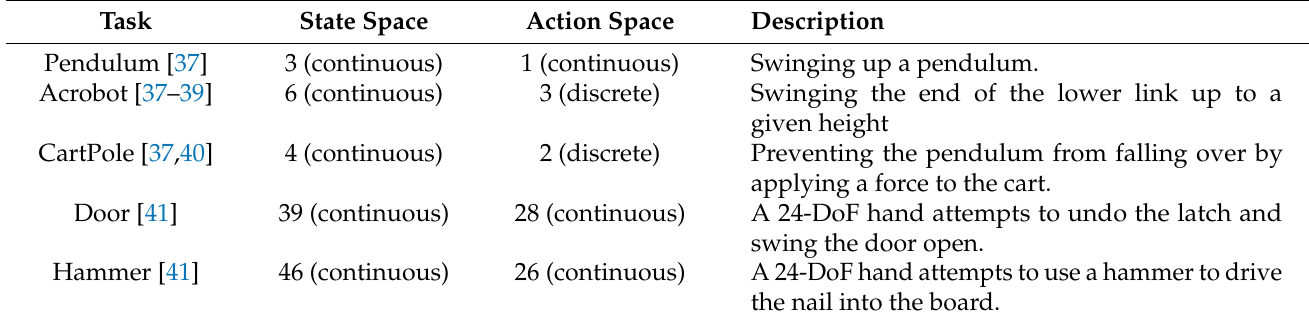
Table 1. Description of five simulated environments used in our experiment.